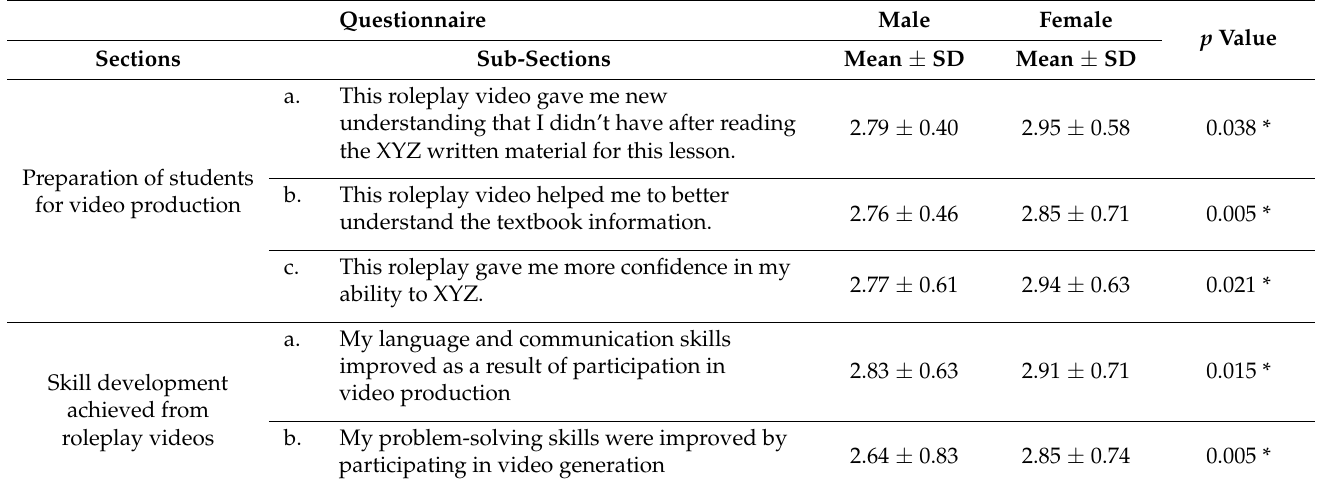
Table 2. Comparison of feedback responses for roleplay videos in relation to gender of the